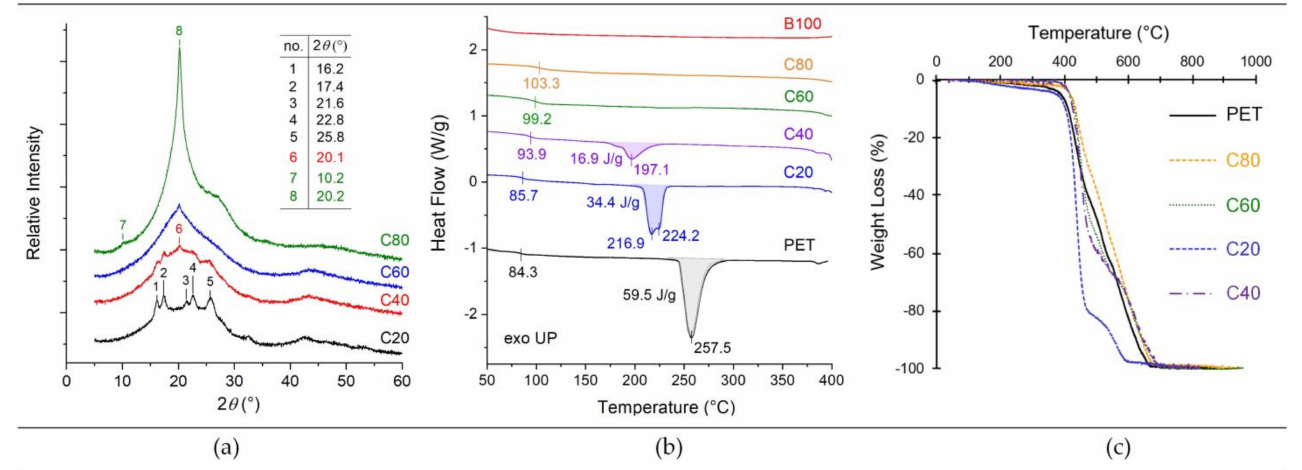
Figure 3. ( a ) XRD patterns of copolyesters C20–C80. ( b ) DSC thermograms for PET, copolyesters C20–C80, and homopoly- mer HBCA (B100) in the first heating cycle at a rate of 20 K/min in an inert atmosphere. ( c ) TGA data for PET and C20–C80 copolyesters in air at a heating rate of 10